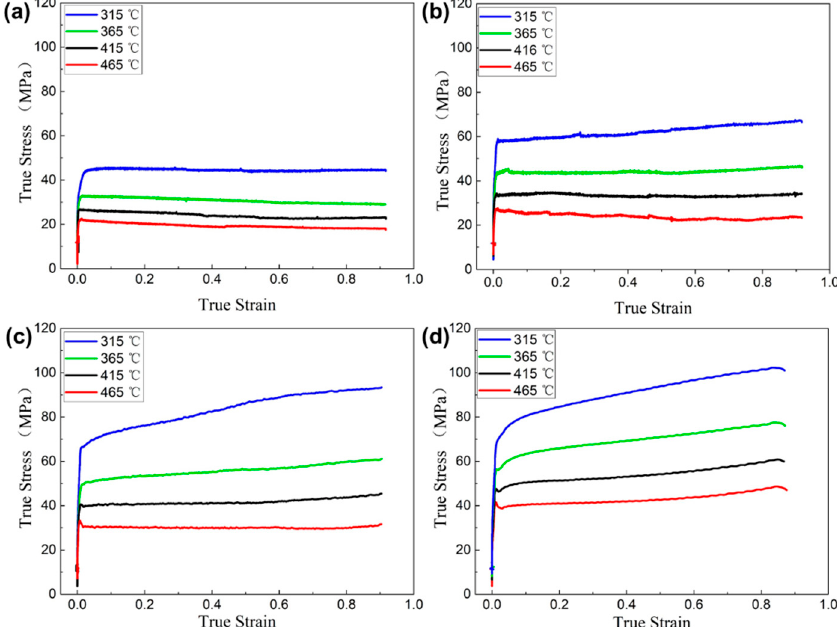
Figure 5. The true stress–strain curve of the second layer of the gradient alloy by spray deposition: ( a ) 0.001 s − 1 , ( b ) 0.01 s − 1 , ( c ) 0.1 s − 1 , and ( d ) 1 s − 1 .